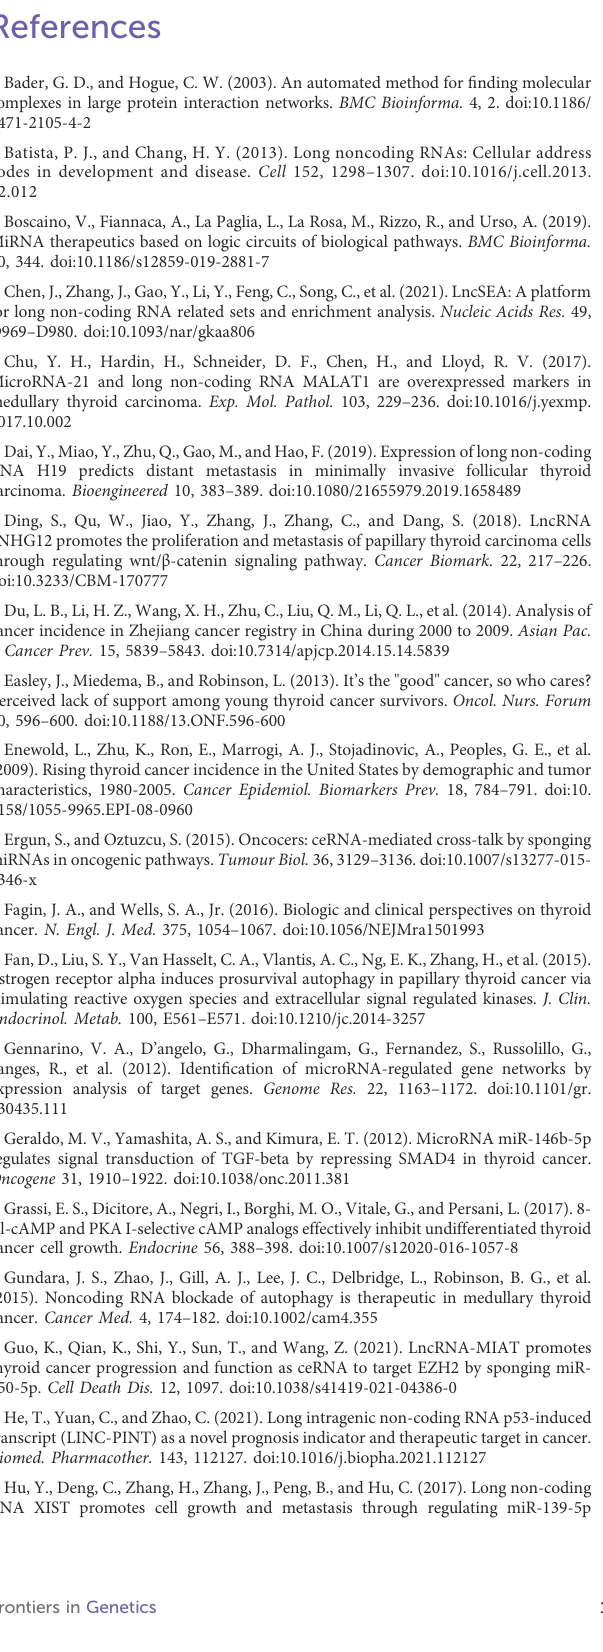
SUPPLEMENTARY TABLE S4 Immunecellin fi ltration estimation scores of TCGA THCA patients. SUPPLEMENTARY FIGURE S1 Gene ontology enrichment of mRNAs in module 1 and module 2. SUPPLEMENTARY FIGURE S2